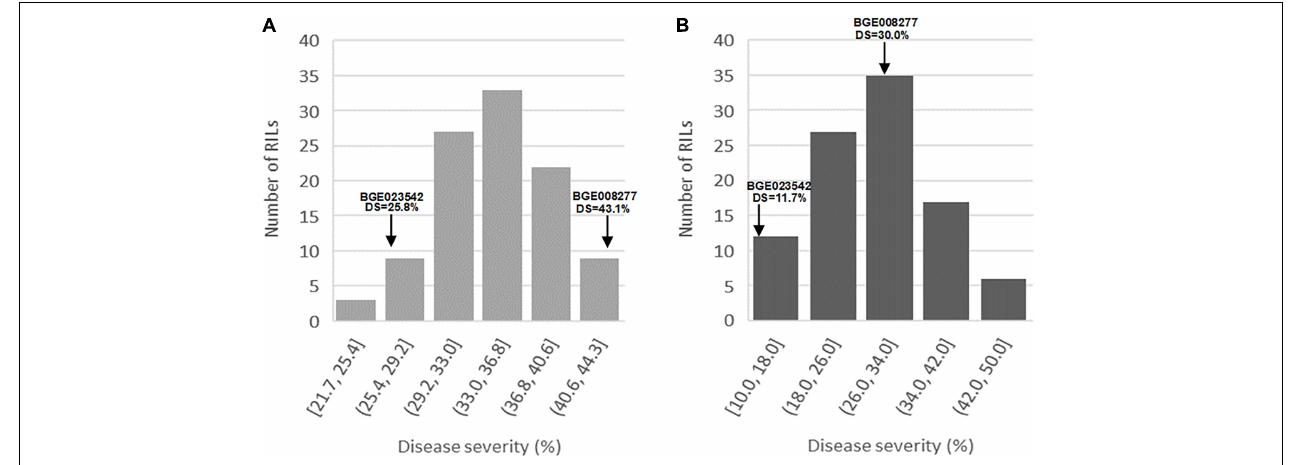
FIGURE 1 | Frequency distributions of the Lathyrus cicera recombinant inbred line (RIL) population (BGE023542 × BGE008277) disease severity (DS) after inoculation with Uromyces pisi : (A) under growth chamber (controlled conditions) and (B) under semi-controlled field conditions. The average values of U. pisi DS of the two parental lines are indicated with arrows. TABLE 1 | Pearson’s correlation coefficients determined among rust disease severity (DS) and expression of genes related to rust resistance in the Lathyrus cicera RIL population (BGE023542 × BGE008277). DS Growth